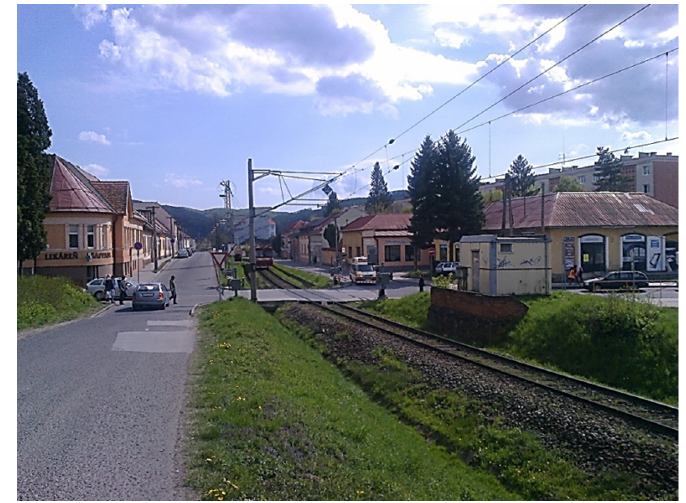
Figure 2. Buildings in the vicinity of the assessed location ZV1/ZV2 Zvolen.